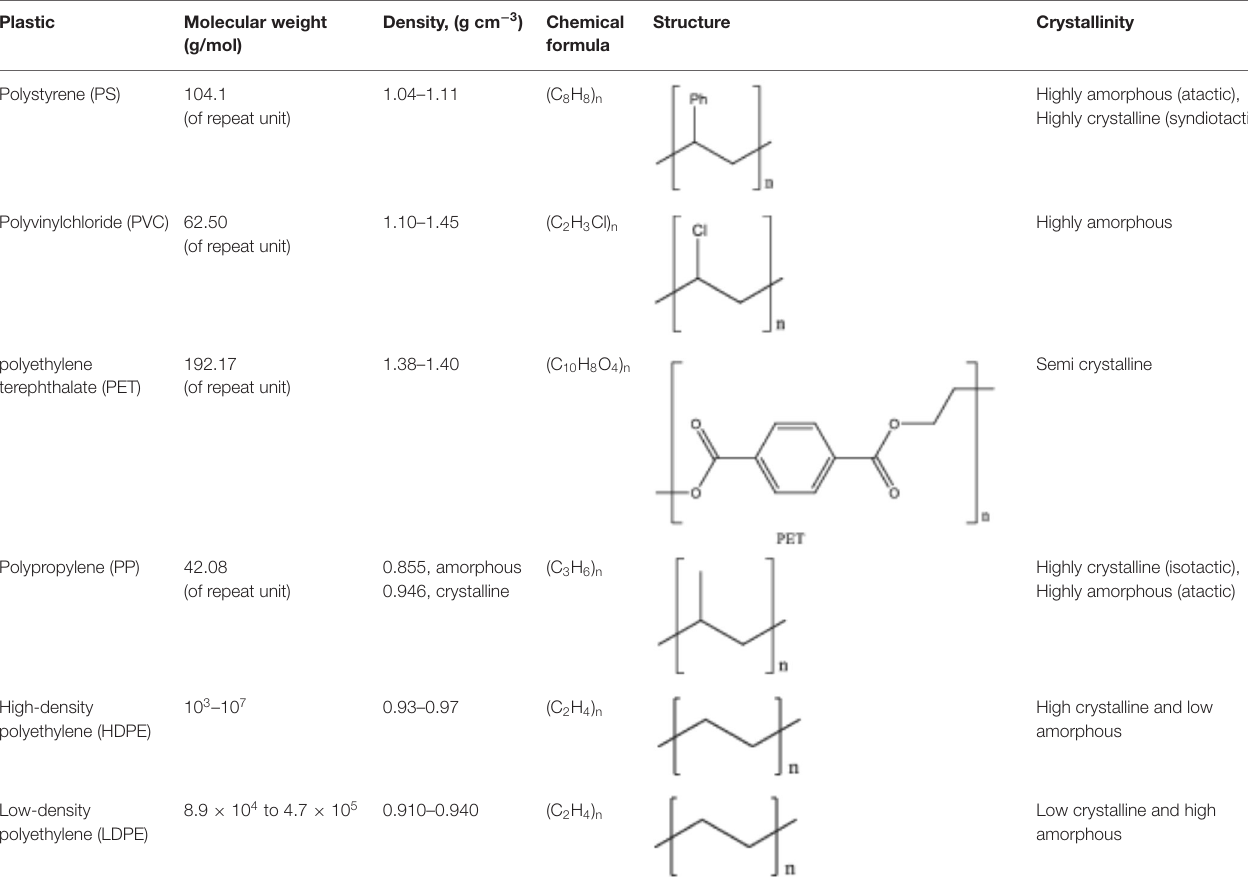
TABLE 2 | Properties and structure of polymers commonly found in plastic